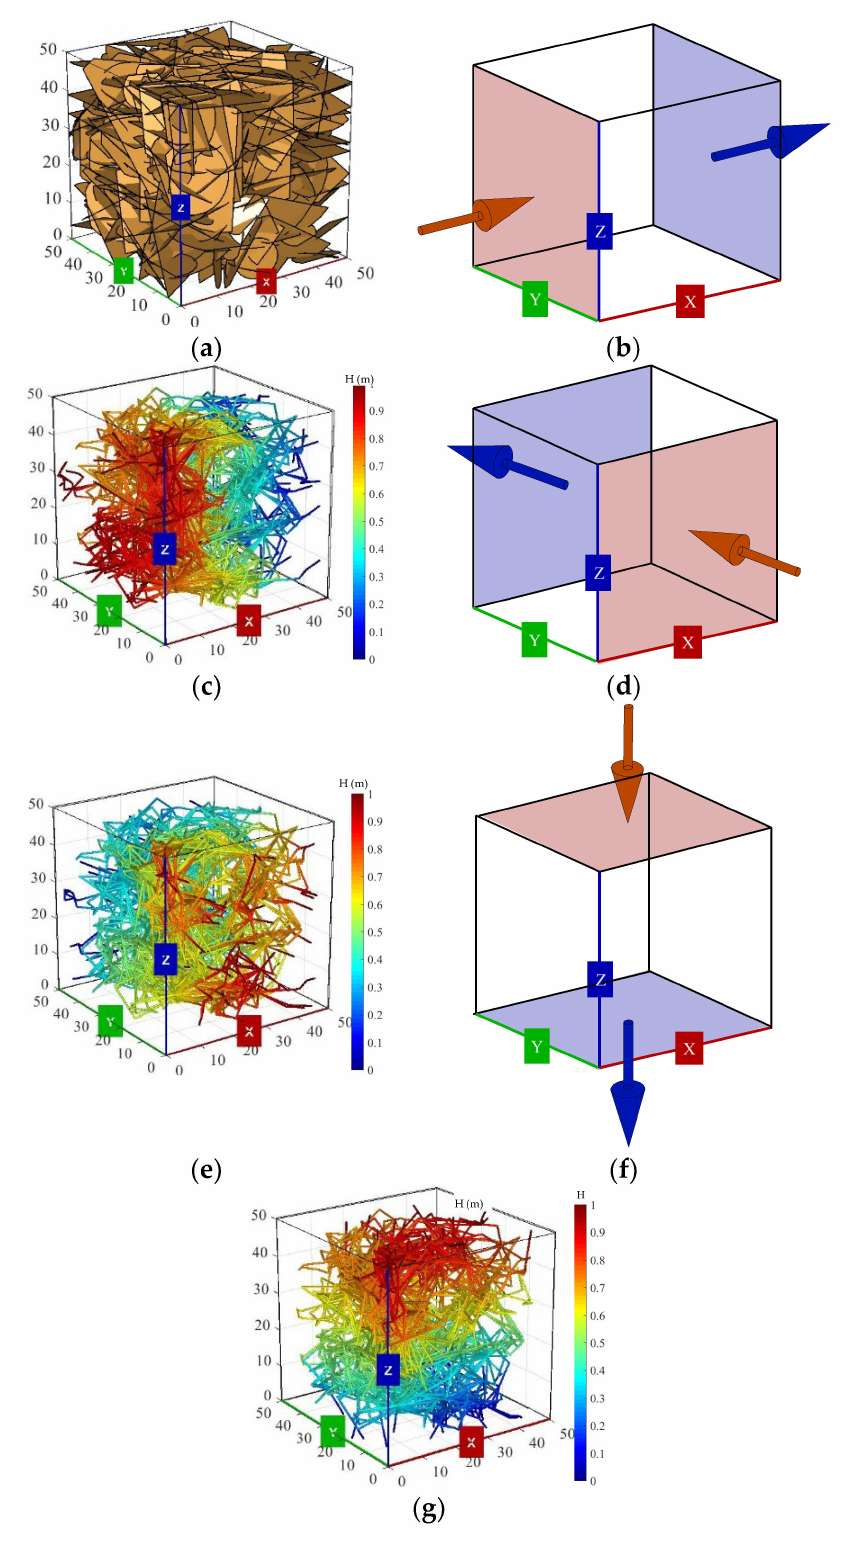
Figure 12. Hydraulic boundary conditions of sub-models and corresponding distributions of water heads. ( a ) A simple DFN sub-model; ( b ) Flow direction 1; ( c ) Water head distribution for flow direction 1; ( d ) Flow direction 2; ( e ) Water head distribution for flow direction 2; ( f ) Flow direction 3; ( g ) Water head distribution for flow direction